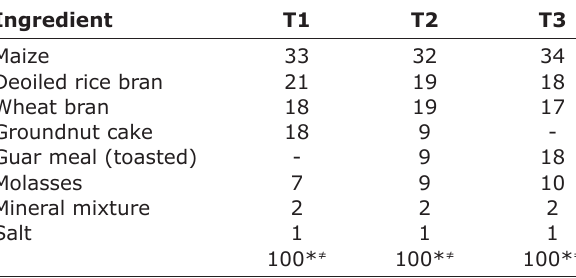
Table-1: Ingredient composition (g/kg) of feed ration. Ingredient